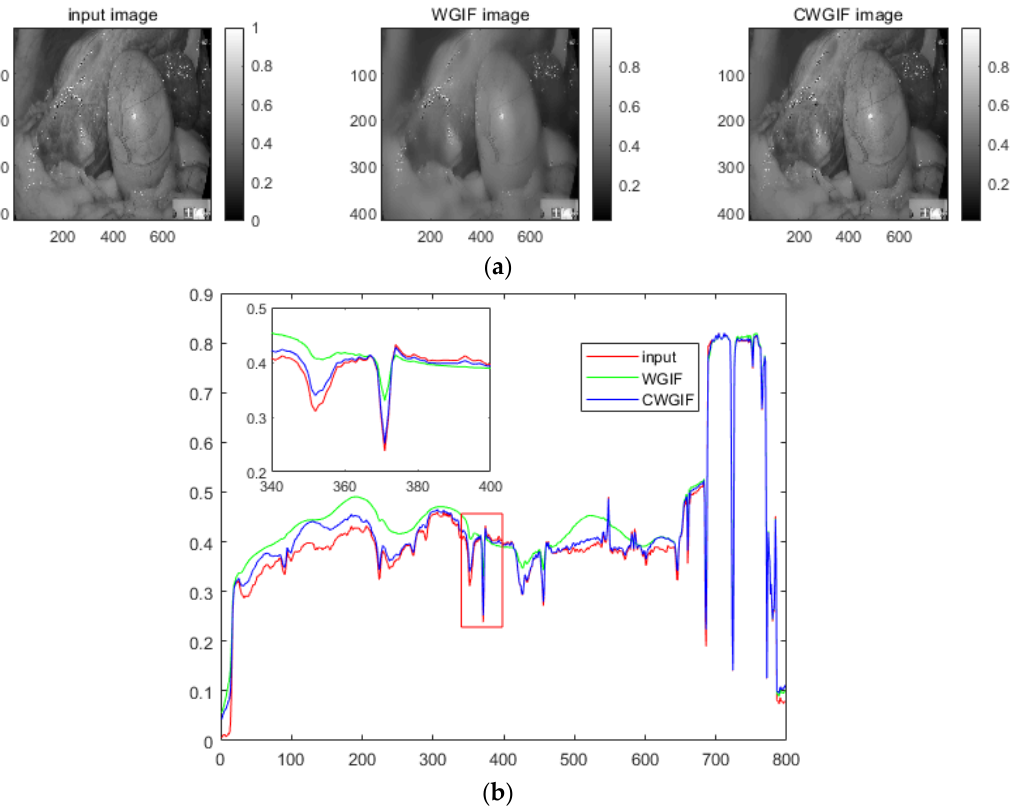
Figure 7. ( a ) input and WGIF and CWGIF image, ( b ) The image is obtained by outputting any row in a two-dimensional coordinate system. Where red is the input image, green is the resulting map of the WGIF method, and blue is the resulting map of the CWGIF method.